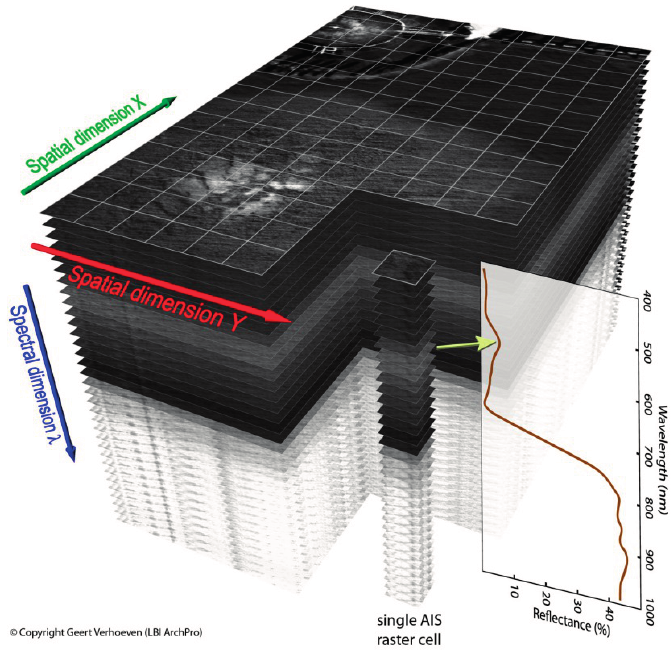
Figure 1. Visualization of an AIS data cube.